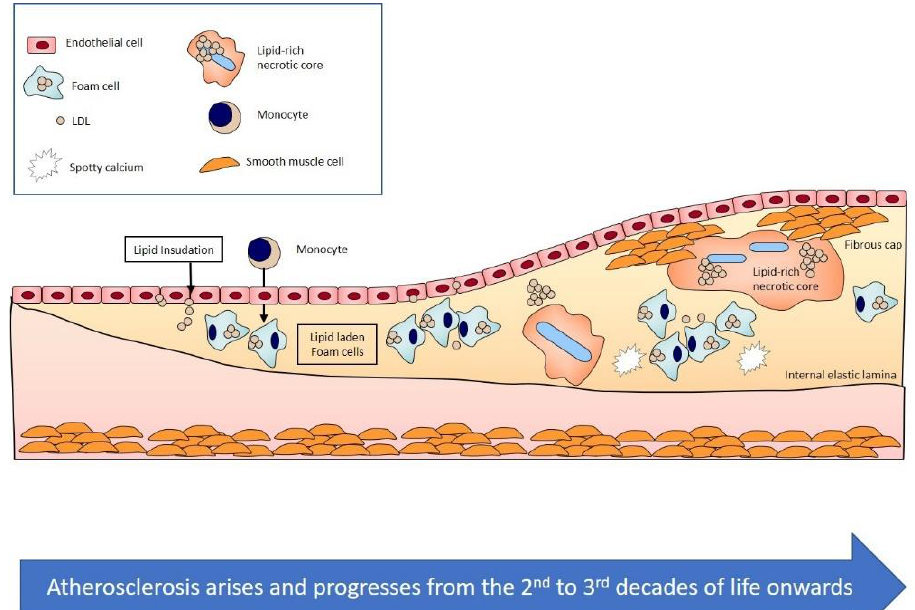
Figure 1. Schematic representation of atherogenesis. Atherosclerosis develops from the second and third decade of life onwards in Western populations and is characterized by the gradual accumulation of lipid-rich material within the intimal layer of arteries (Figure adapted from [14]).